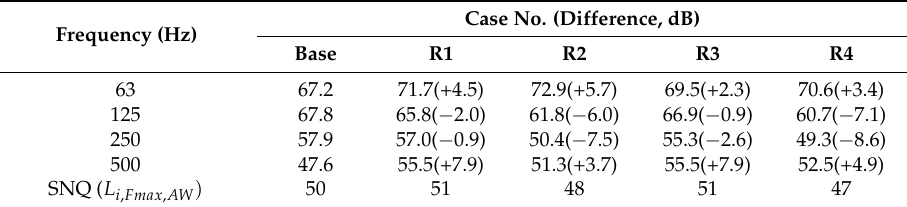
Table 14. Impact ball’s test results in 1/1 Octave